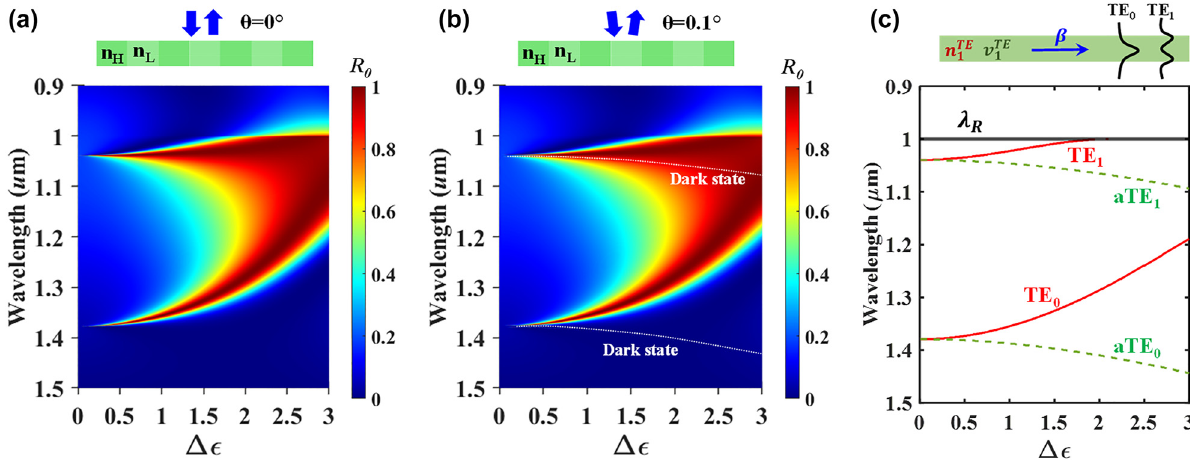
− n 2 Figure 5: Band progression relative to index modulation strength Δ 𝜀 = n 2 . The lattice has parameters ( Λ = 1 μ m, F = 0.5 and H = 0.5 μ m) while √ H L = + (1 − F ) n 2 Fn 2 ). Reflectance R ( Δ 𝜀 , 𝜆 ) is found by RCWA at (a) normal incidence 𝜃 = 0 ◦ and (b) keeping a fixed average refractive index ( n avg 0 H L off-normal incidence 𝜃 = 0.1 ◦ . In the symmetric system of (a), two (upper) modal bands appear. In (b), at slightly broken symmetry, two hidden dark states appear as lower bands. (c) Mode loci of the equivalent TE slab applying the symmetric and asymmetric Rytov EMT where the 𝜆 Rayleigh wavelength. As Δ 𝜀 increases, the pair of bands split in symmetric and asymmetric GMRs, with an excellent match to (b). Interestingly, the mode is highly separated from the upper band of the TE mode, which leads to the isolated singular states of central lower band of the aTE 0 0 importance.